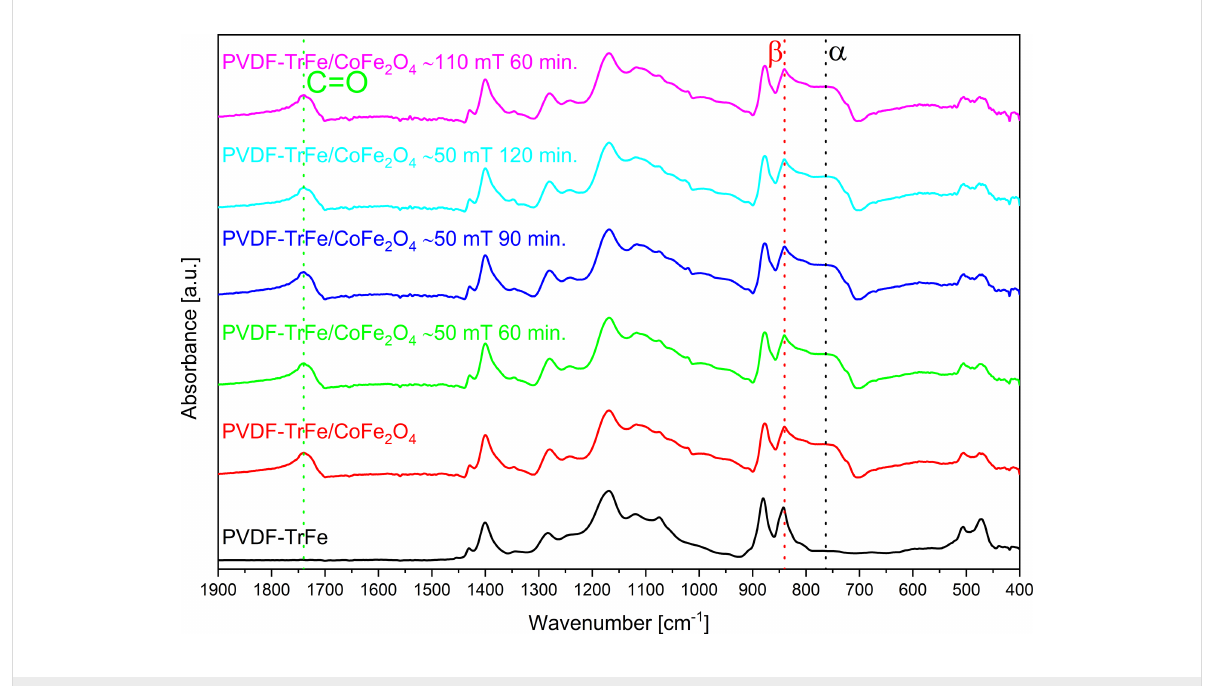
Figure 1: FTIR spectra of the produced samples: i) neat PVDF-TrFE; ii) PVDF-TrFe filled with CoFe 2 O 4 nanoparticles at 5 wt %; iii) the PVDF-TrFe filled with CoFe 2 O 4 at 5 wt % and poled for 60 min at 65 °C with a magnetic field of 50 mT; iv) the PVDF-TrFe filled with CoFe 2 O 4 at 5 wt % and poled for 90 min at 65 °C with a magnetic field of 50 mT; v) the PVDF-TrFe filled with CoFe 2 O 4 at 5 wt % and poled for 120 min at 65 °C with a mag- netic field of 50 mT; vi) the PVDF-TrFe filled with the CoFe 2 O 4 at 5 wt % and poled for 60 min with a magnetic field of 110